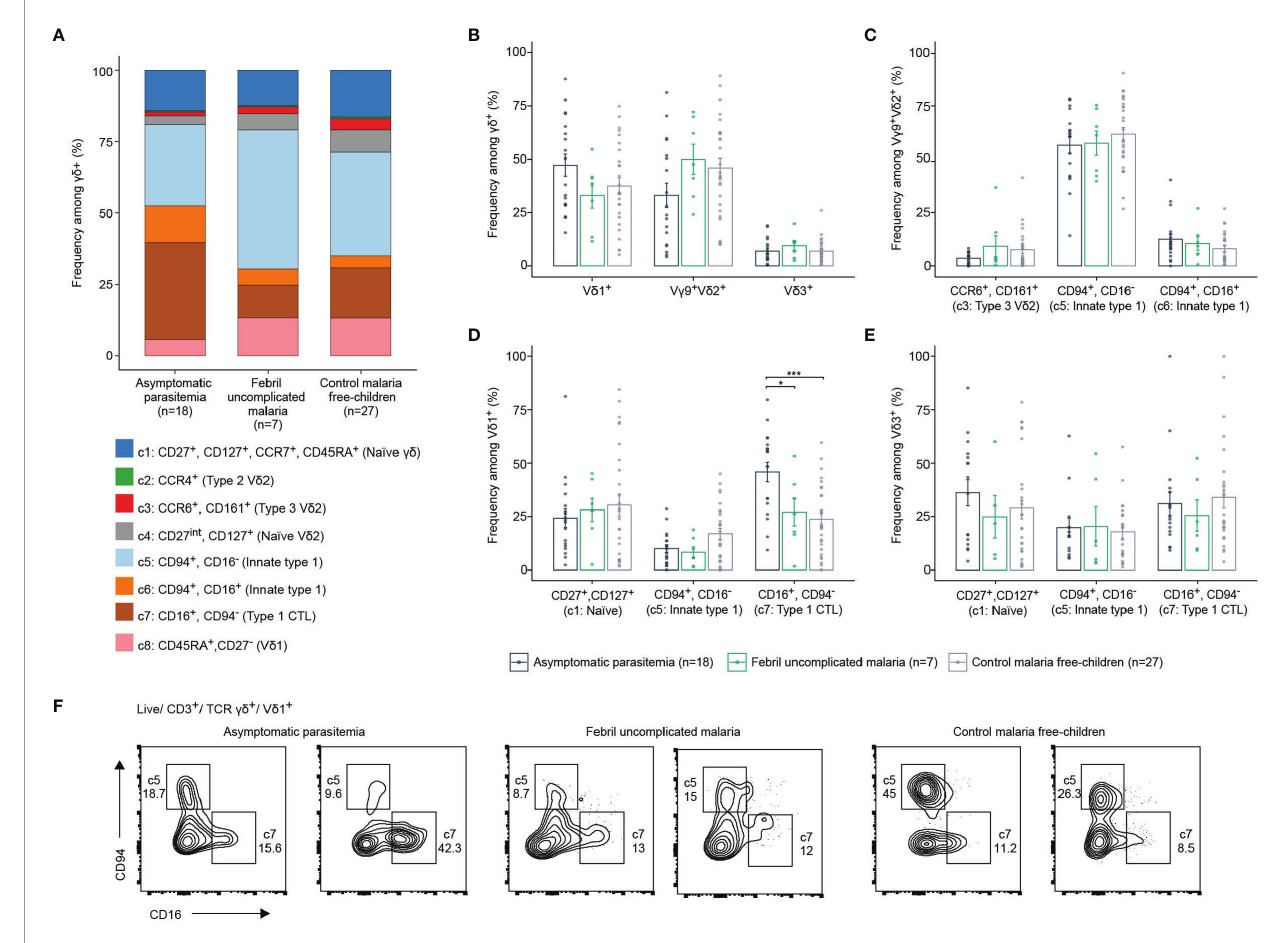
FIGURE 3 | gd T cell effectors in malaria-free and malaria-positive children. (A) Frequency of each identi fi ed cluster of total gd T cells in children with asymptomatic parasitemia (n=18), febrile uncomplicated malaria (n=7) or control malaria free-children (n=27). (B) Comparison of V d 1+, V g 9 + V d 2 + or V d 3 + frequencies of gd T cells according to malaria status of children. (C) Comparison of CCR6 + /CD161 + , CD94 + /CD16 - or CD94 + /CD16 - frequencies among V g 9 + V d 2 + according to malaria status of children. (D) Comparison of CD27 + /CD127 + , CD94 + /CD16 - or CD16 + /CD94 - frequencies among V d 1 + or (E) V d 3 + . Error bars indicate mean ± SD, data analysed by ANOVA and Tukey post-hoc test. *p < 0.05, ***p < 0.001. (F) Flow cytometric plots of CD94/CD16 on V d 1 + T cells in representative samples from two asymptomatic parasitemia, two febrile uncomplicated malaria or two control malaria